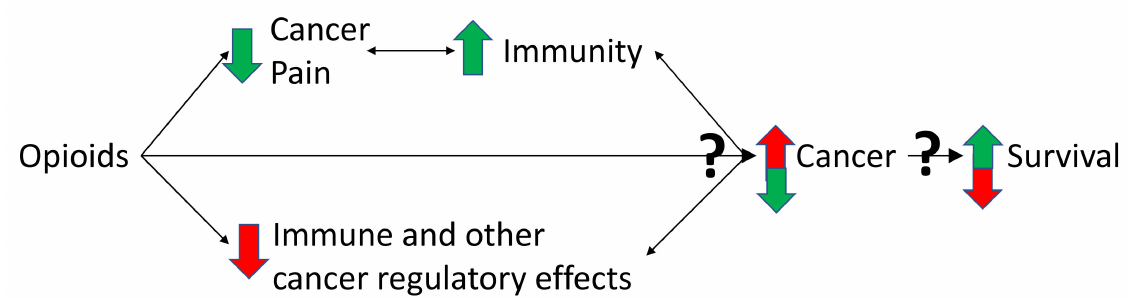
Figure 2. Triangulation of the effects of opioids on pain, immunity and cancer. Cancer can cause pain, by nociceptive, neuropathic, and inflammatory mechanisms, partly caused by the immune response to cancer [1,2,53]. It is this pain state that necessitates opioid use [1,2,49]. Pain is potentially immunosuppressive which might worsen cancer outcomes in some cancer types [44,51,52]. By reducing pain, opioids might have beneficial effects on immune function, the cancer and potentially survival [44,51,52]. However, some opioids suppress immune function, which might decrease anti- tumour immunity and promote cancer growth [6]. Furthermore, there are non-immune effects of opioids on cancer cell regulation [17–20,28]. Opioids can also act directly on the MOR on cancer and non-cancer cells of the tumour microenvironment [28,30]. Together, these multiple effects converge to influence cancer growth and survival [11,12,54]. The balance of these effects is critical and might be dependent on the immune properties of the opioid used and the cancer type [6,15]. Many of the aforementioned effects are bidirectional (depicted by double arrowed lines in the figure). The immune system, via microglia and cytokines, influences the pain state [55]. Activated immune cells can also produce endogenous opioids, as well as morphine [56]. The immune system and the cancer are constantly influencing each other, with processes such as immunoediting and immunosculpting [57]. The aforementioned interactions lead to either cancer cell destruction or growth. How the cancer progresses influences survival. Green arrows depict a beneficial effect, red arrows depict a detrimental effect of opioids on the immune system, cancer development and survival. Question marks are used to highlight uncertainly of the net balance of effects, which might vary depending on the